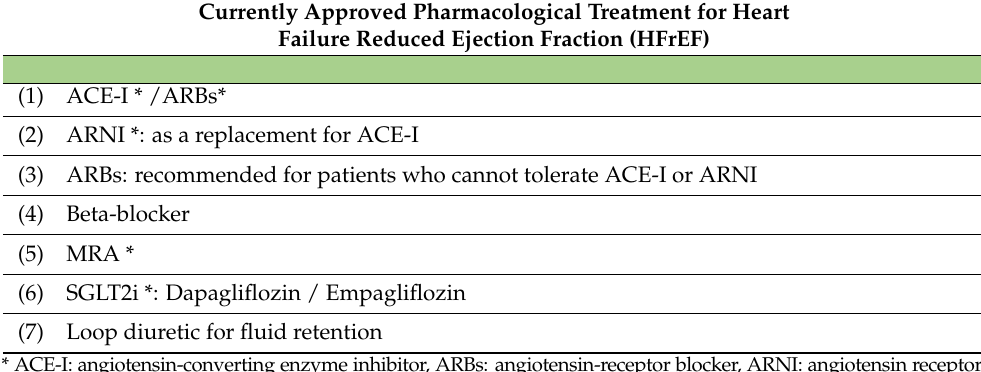
Table 1. Class I therapy for a patient with HFrEF. * ACE-I: angiotensin-converting enzyme inhibitor, ARBs: angiotensin-receptor blocker, ARNI: an- giotensin receptor-neprilysin inhibitor, MRA: mineralocorticoid receptor antagonists, SGLT2i: so-